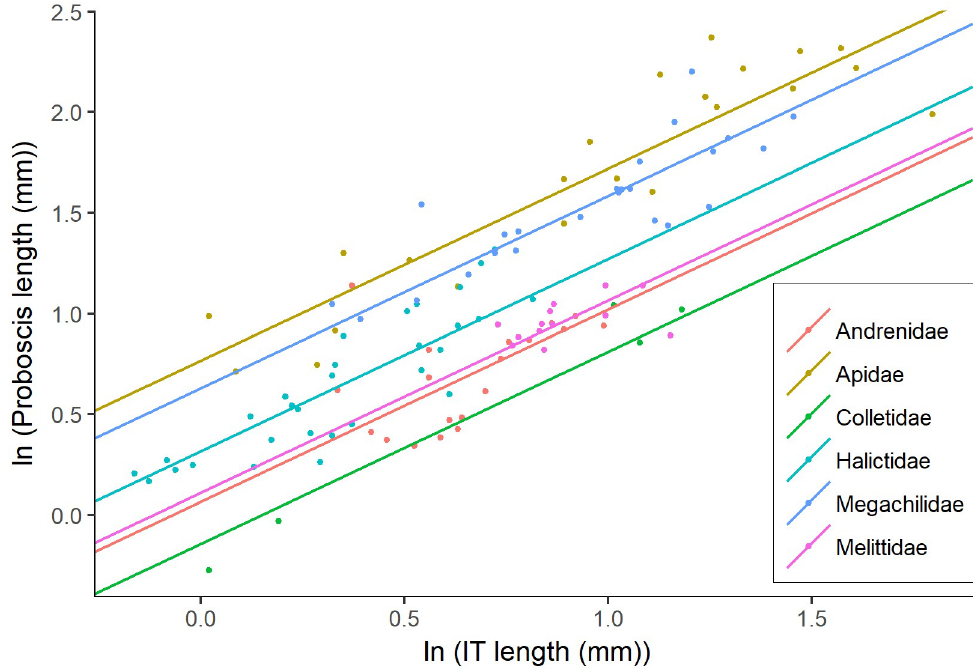
Fig 2. Allometric relationship between IT and proboscis length. The relationship between intergular distance (IT) and proboscis length in 11 species from Melittidae and 100 species (Cariveau et al. [12], S2 Table) from Apidae, Megachilidae, Andrenidae, Collectidae and Halictidae. The mean IT and proboscis length for each species is depicted as a point. Each bee family is represented by a colour. The fitted lines are based on regression coefficients from model outputs. Proboscis length and IT are both ln